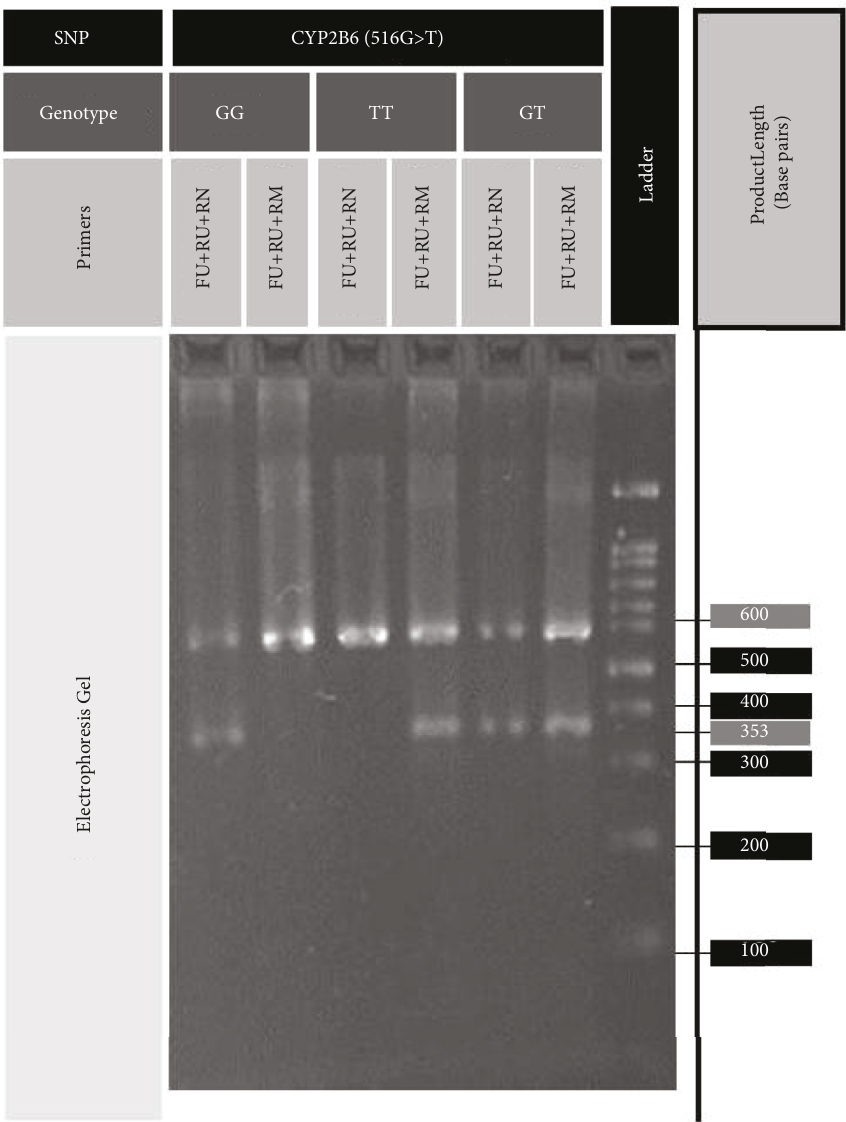
Figure 3: CYP2B6 ∗ 6 gene electrophoresis findings for three samples with genotypes of GG, TT, and GTfrom left to right. FU, forward outer primer; RU, reverse outer primer; RN, reverse nonmutant primer, RM, reverse mutant primer; the leftmost well is filled with a 100bp DNA